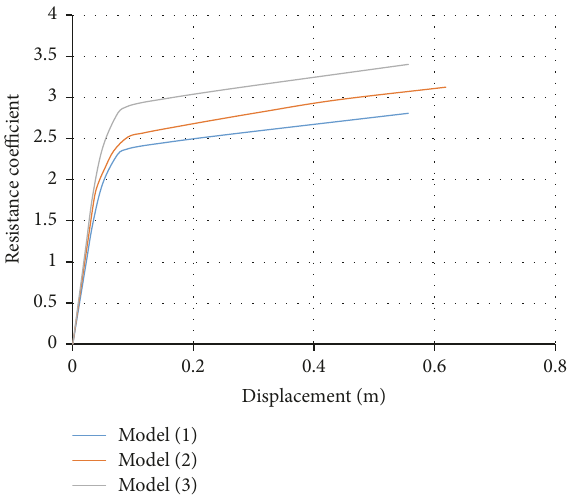
Figure 19: Displacement-resistance curve of the three models with different steel ratio after the bottom middle column was removed.